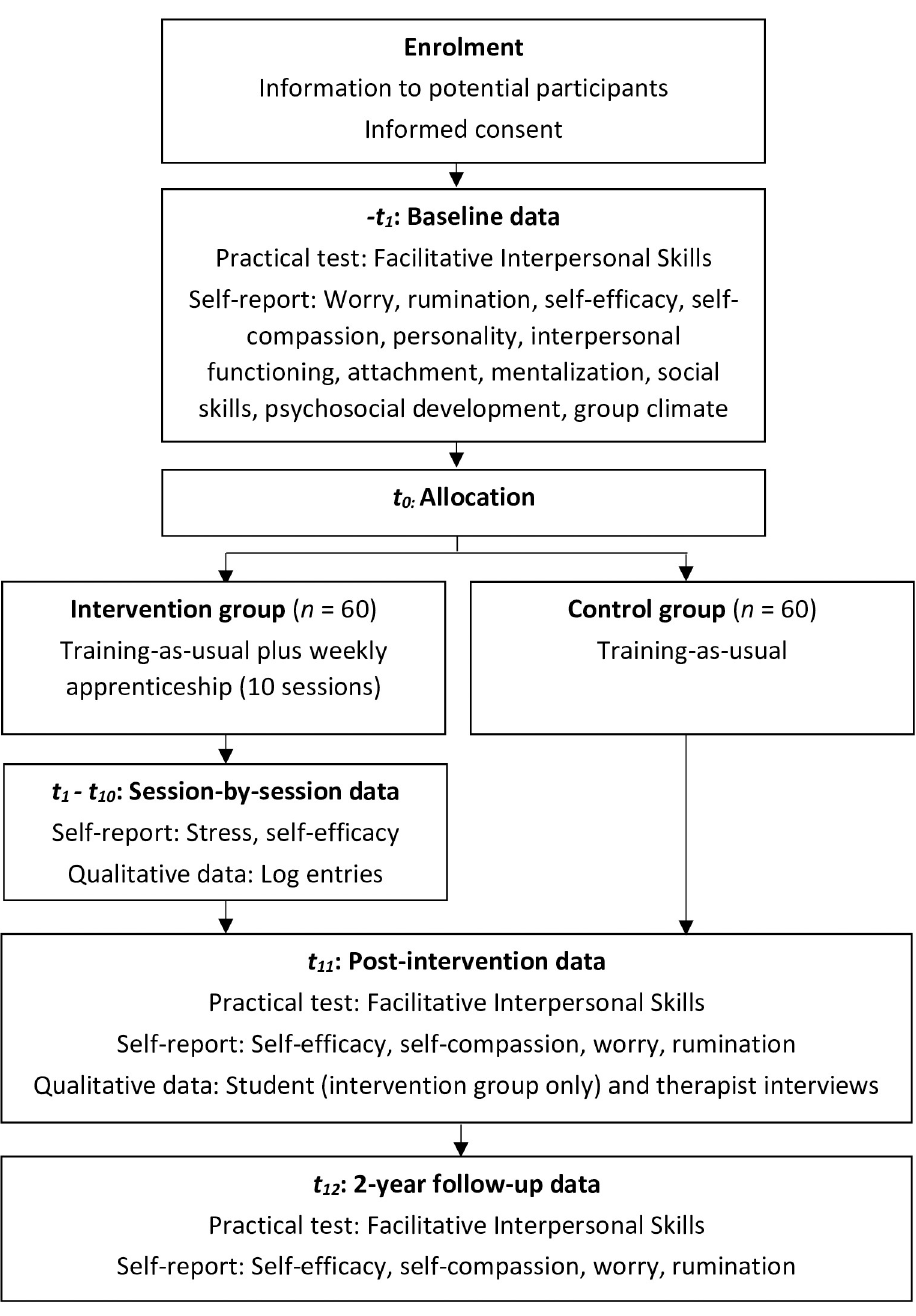
Fig 1. Flow chart with an overview of the study